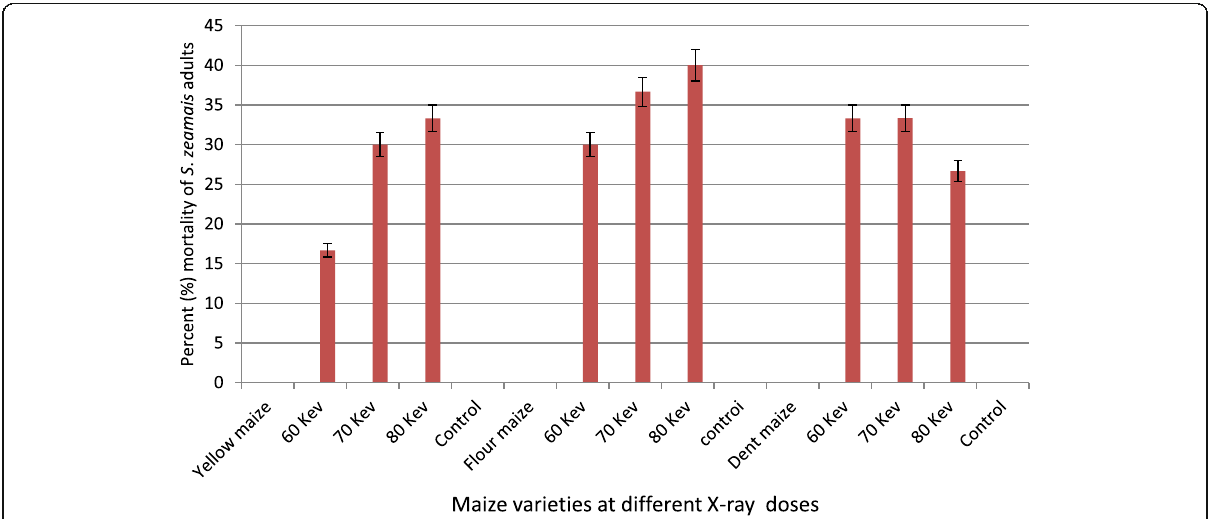
Fig. 2 Effect of X-ray exposure dose (KeV) on the cumulative mortality of Sitophilus zeamais Motschulsky adults after 168 h (7